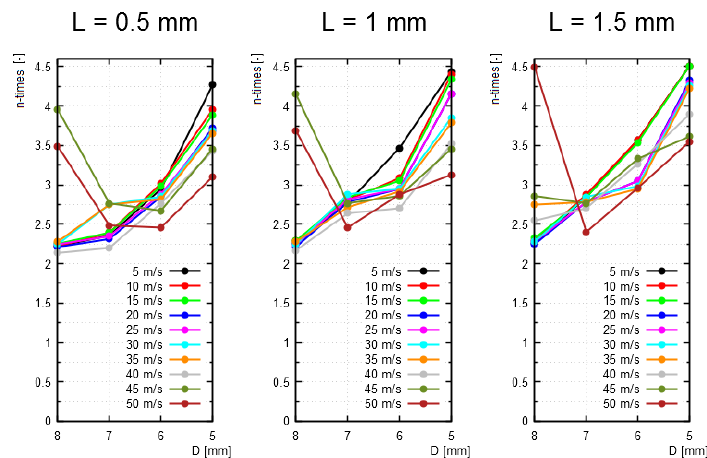
Figure 12. Influence of impacting velocity on a time rise (L - length of the pulse shaper, D - diameter of the pulse shaper